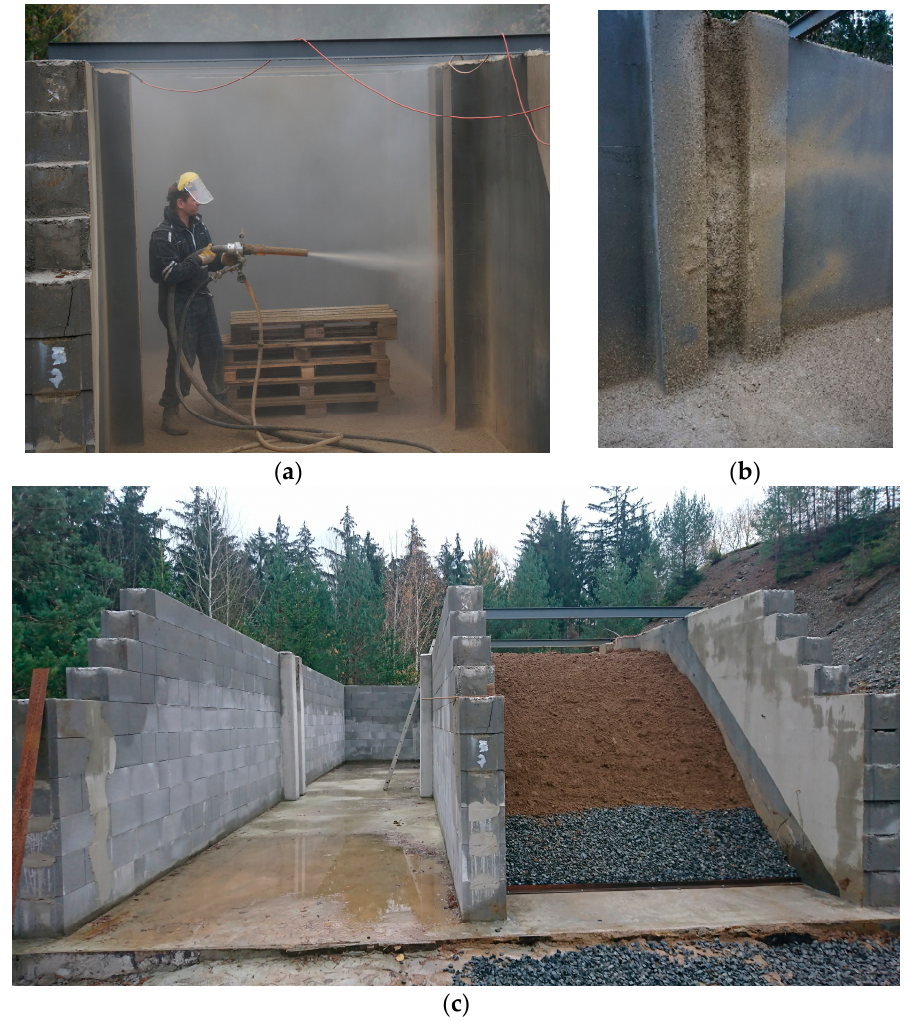
Figure 8. ( a ) Spraying of the bentonite between the concrete ribs during the construction of the first dam; ( b ) final sealing layer between the concrete ribs; ( c ) first dam following